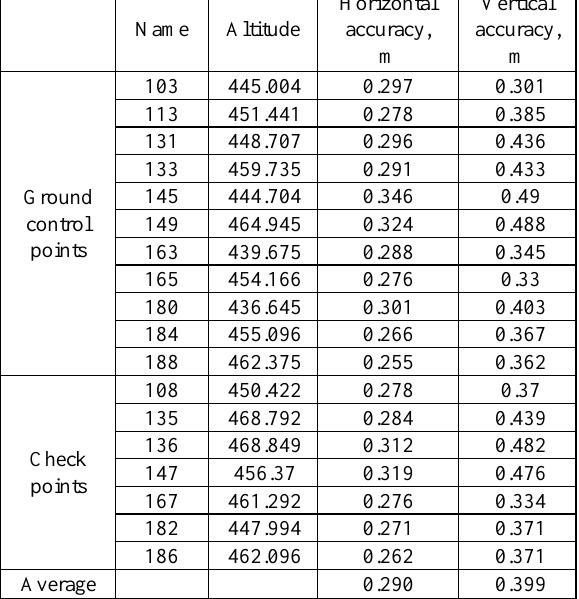
Table 1. GPS accuracy of control points For georeferencing purposes, ground-control points (GCP) were used – 35 x 35 cm yellow-black squares with the easily definable centre point. In total 16 GCPs were spread across the GPR survey territory. The position of the GCP was collected by GPS receiver with the mean horizontal accuracy of 0.29 m